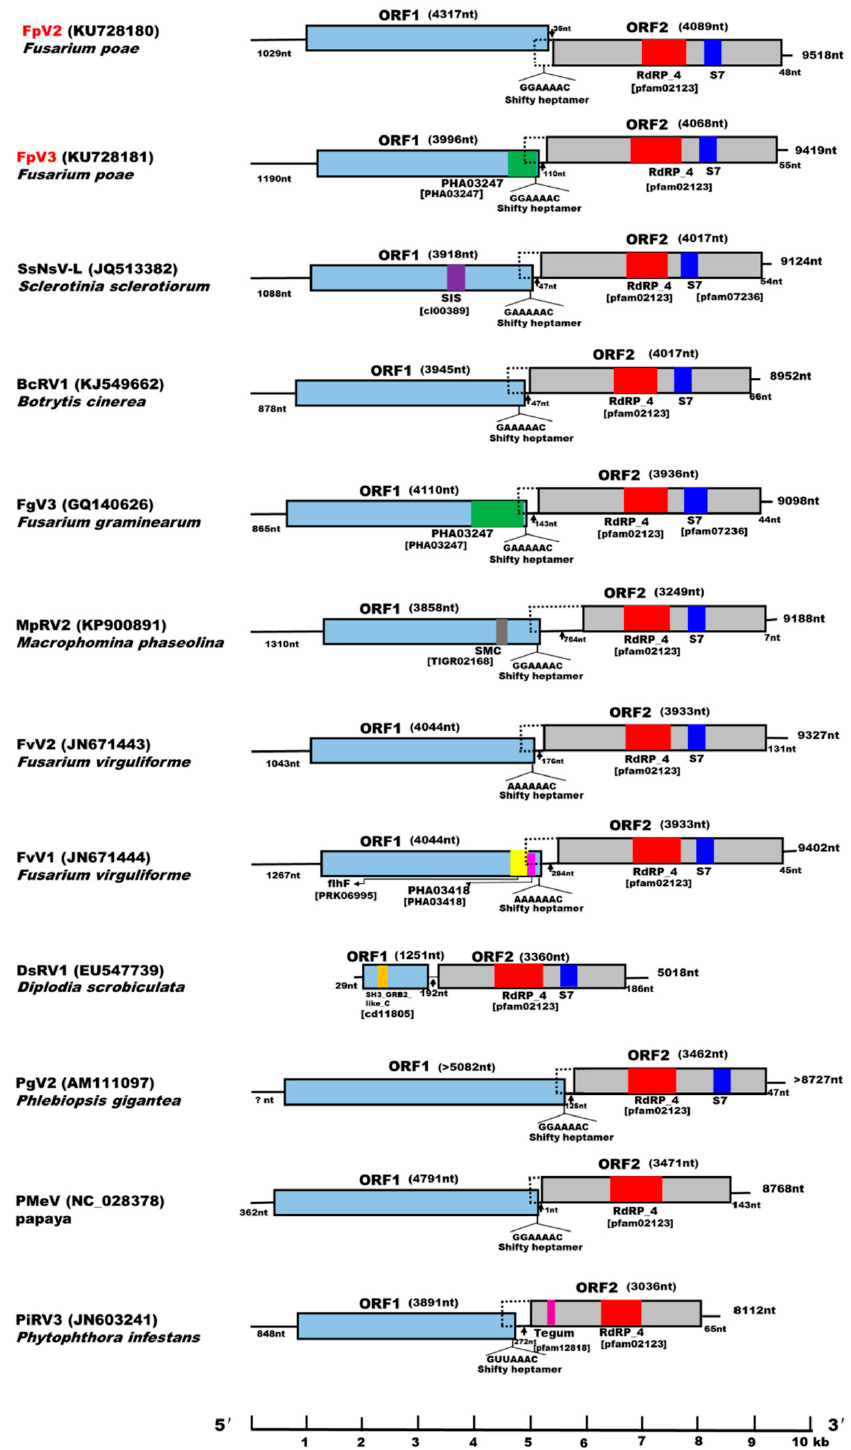
Figure 2. Genomic organization of FpV2, FpV3 and comparison with those of related RNA viruses. The genomes of FpV2 and FpV3 are 9518 and 9419 nt in length with two open reading frames (ORFs), respectively. The dotted line box represents a possible extension of ORF2 by frameshifting. The colored boxes and lines stand for ORFs and non-coding sequences, respectively. The boxes in ORF 2 indicate conserved domains containing RNA-dependent RNA polymerase superfamily 4 (RdRP_4, red) and (or) Phytoreo_S7 (S7, blue). The sizes of the 5 1 -UTR, 3 1 -UTR, inter-ORF regions, ORF1, and ORF2 are shown above or below the diagram. A scale bar (1-kb increment) is shown at the bottom. See legend to Figure 4 for abbreviations of the virus